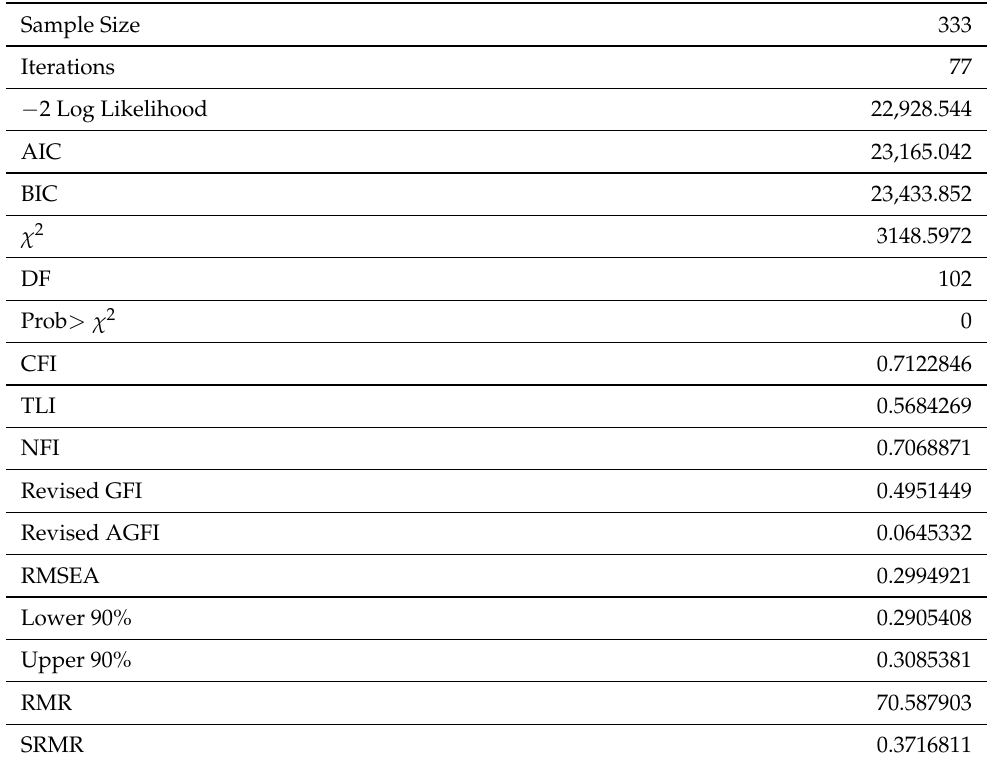
Table 2. Summary of fit for the Italian data (JMP Pro version 16).